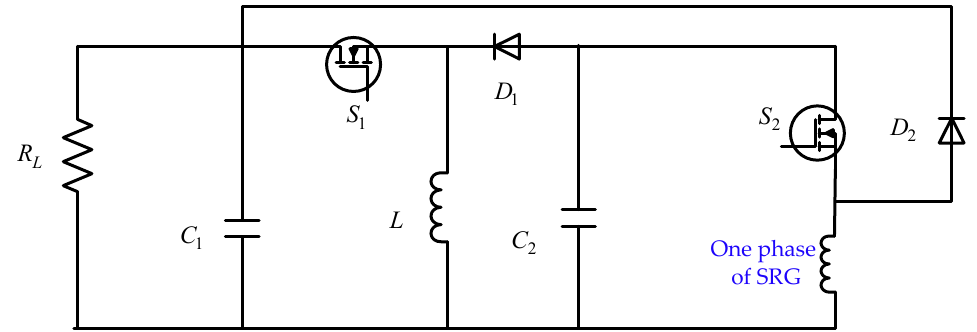
Figure 14. Variable DC link converter (CvDC).